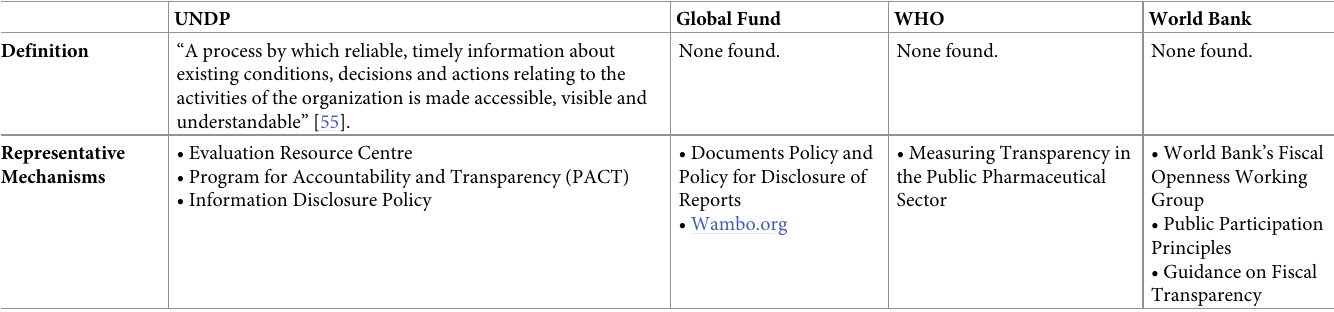
Table 3. Defining and operationalizing transparency.